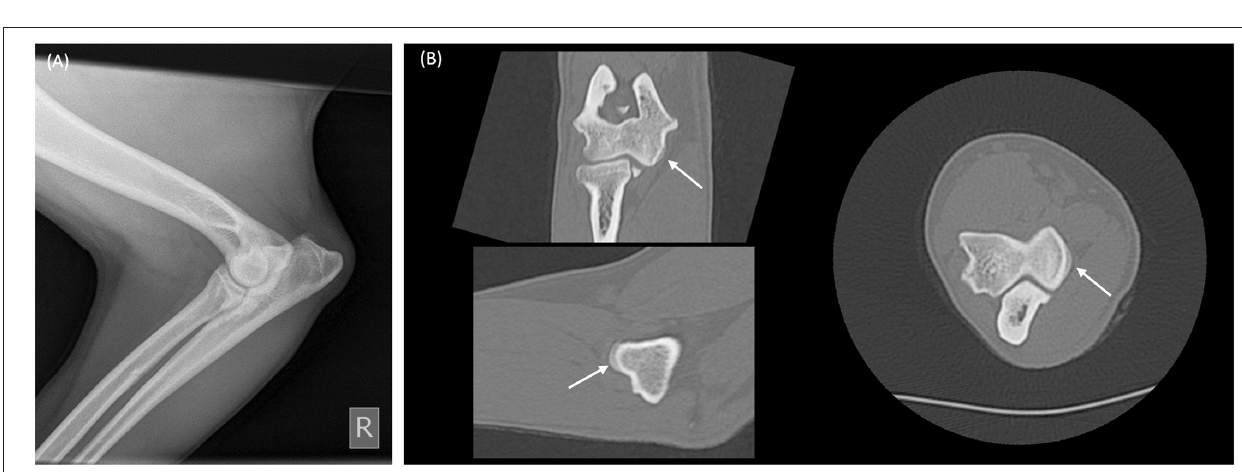
FIGURE 5 | Radiograph and multiplanar reconstruction of a computer tomography (CT) of a canine elbow showing osteophytes are more easily identified on CT compared to radiography. (A) Mediolateral elbow radiograph from a skeletally mature dog showing minimal radiographic change of osteoarthritis. (B) Multiplanar CT reconstruction of the same elbow, demonstrates an occult 2mm diameter osteophyte on the medial humeral condyle (white